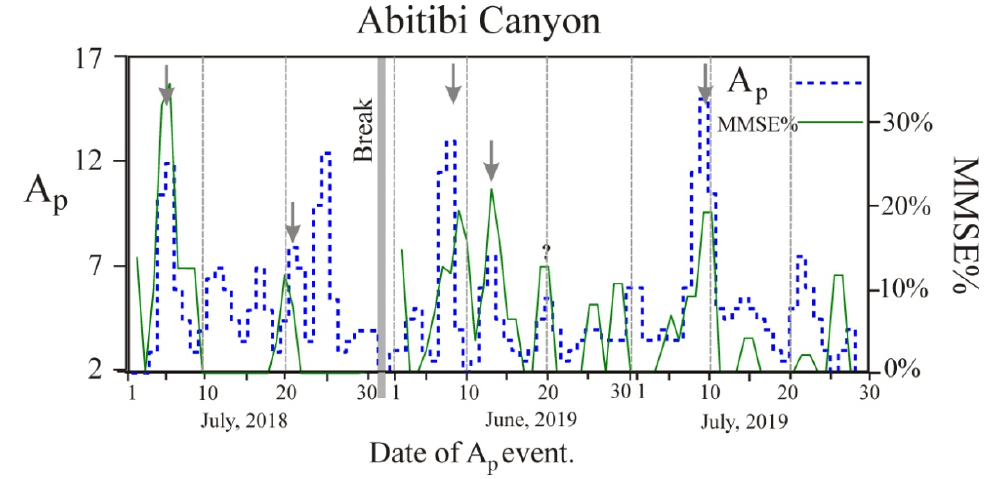
Figure 7. Two-point running means of Ap and the percent of MMSE per day. The MMSE% has been moved to the left by 3 days (i.e., in reality they occurred 3 days later). Arrows refer to significant A p events, which had a co-existing lagged MMSE%. See text for details.